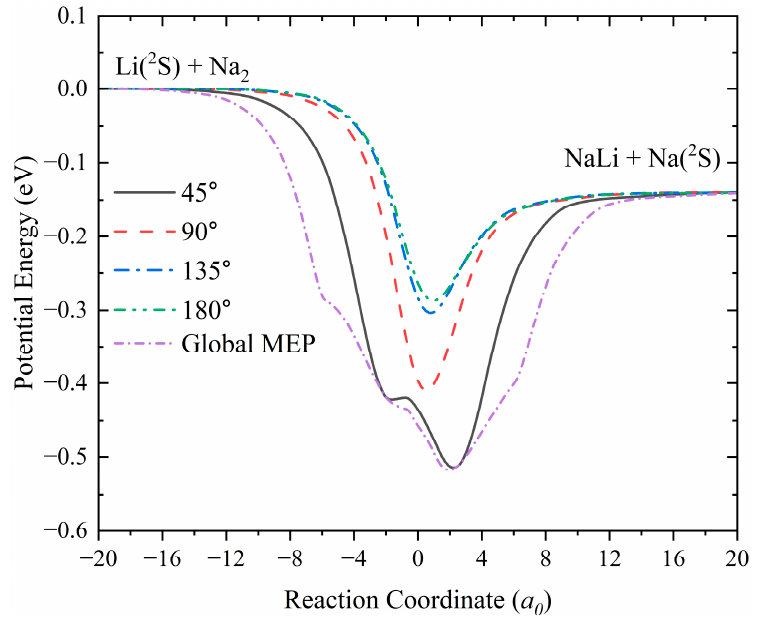
Figure 5. MEPs at four Li − Na − Na angles (45°, 90°,135°, and 180°) and global MEP of the Li( 2 S) + Na 2 → LiNa + Na reaction calculated by the GP PES.